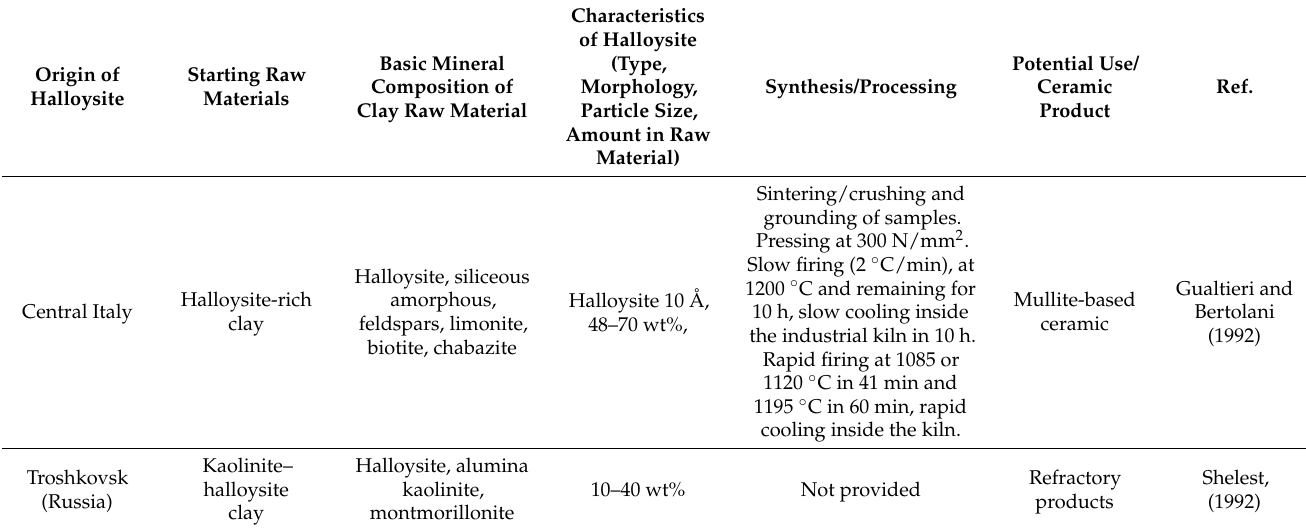
Table 1. Clay materials with halloysite for their potential use in traditional ceramics.